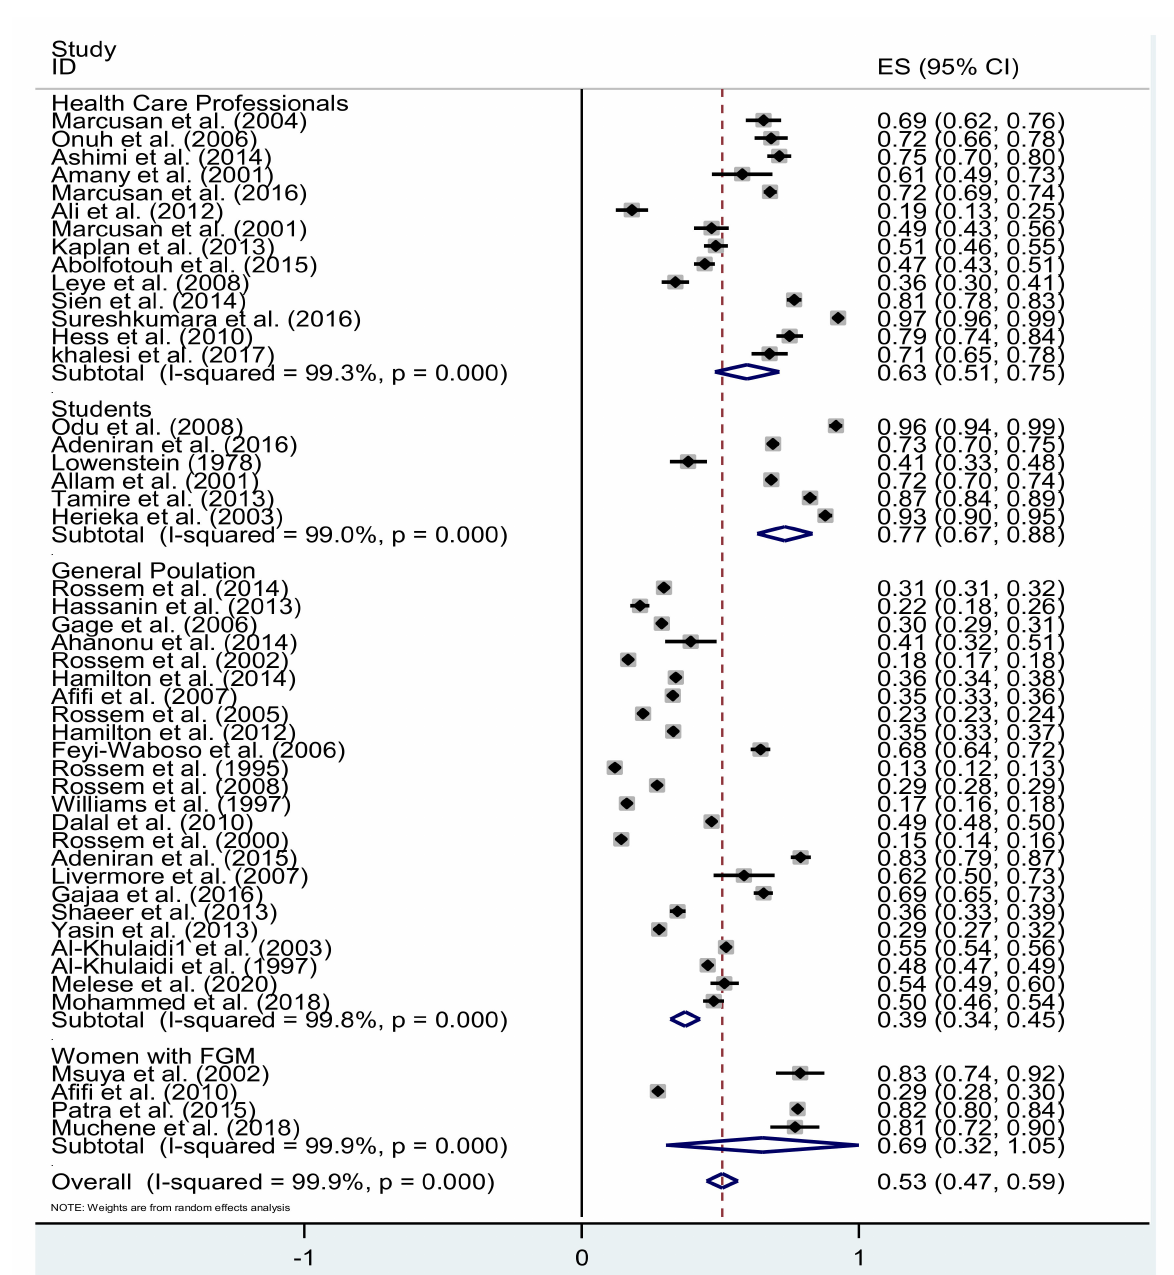
Figure 4. Negative attitudes toward FGM according to type of